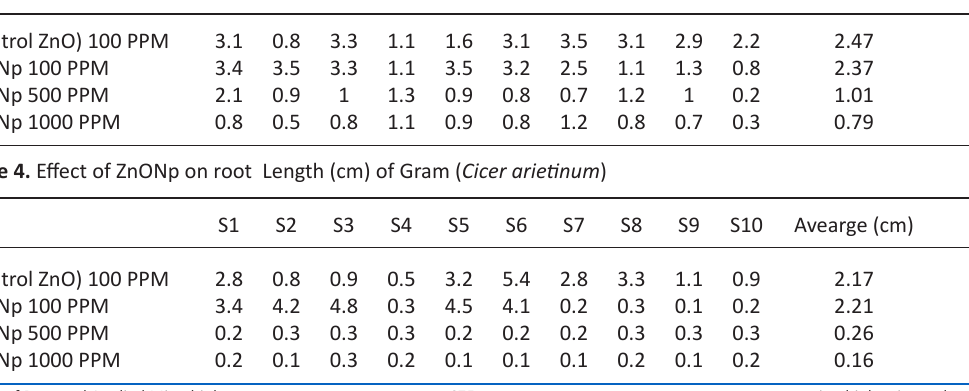
Table 3. Effect of ZnONp on shoot Length (cm) of Gram ( Cicer arietinum ) S1 S2 S3